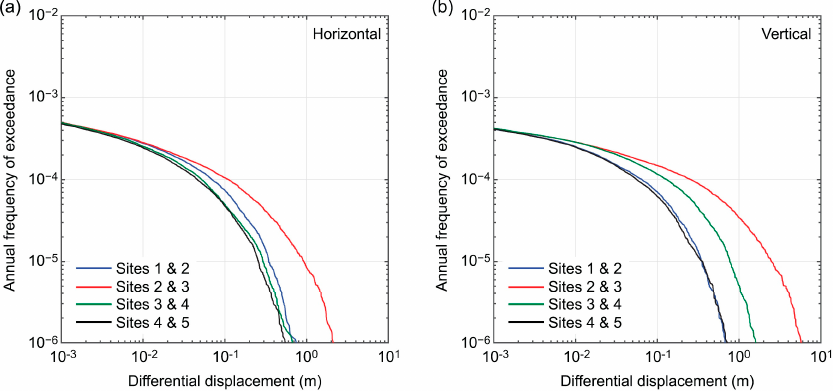
Figure 10. Differential fault displacement hazard curves for four pairs of Sites 1 to 5: ( a ) horizontal displacement and ( b ) vertical displacement.